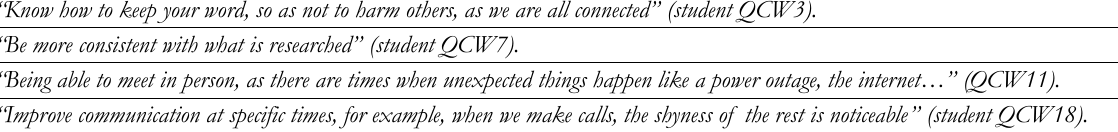
Table 8. Open comments from the students through the questionnaire on cooperative learning, question